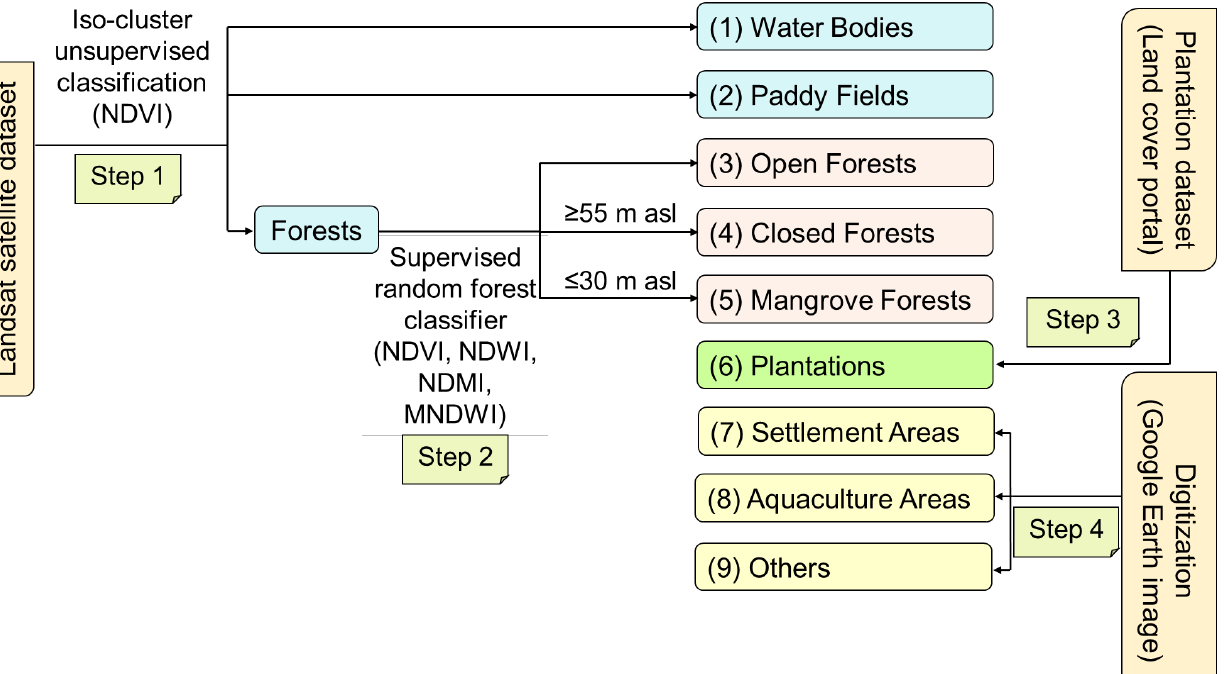
Figure 3. Flow diagram of procedural steps used in hierarchical classification of nine LULC features of Kyunsu township in Southern Myanmar. of Kyunsu township in Southern